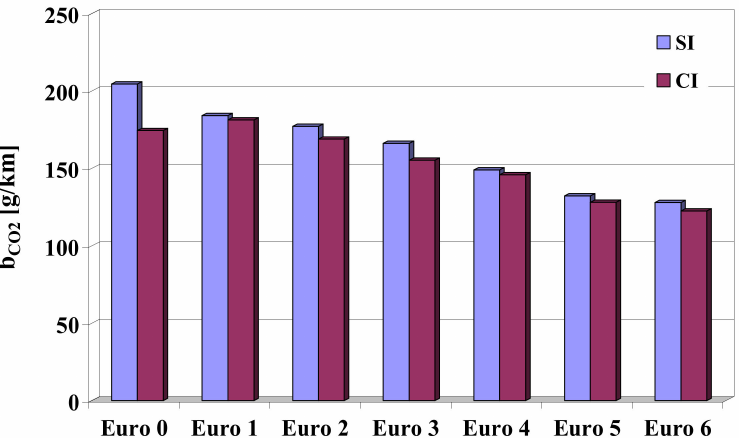
Figure 16. Specific distance emission of carbon dioxide—b CO2 , from hot passenger car engines of Euro 0–Euro 6 pollutant emission categories, spark-ignition engines—SI and compression-ignition engines—CI, under the model vehicle traffic